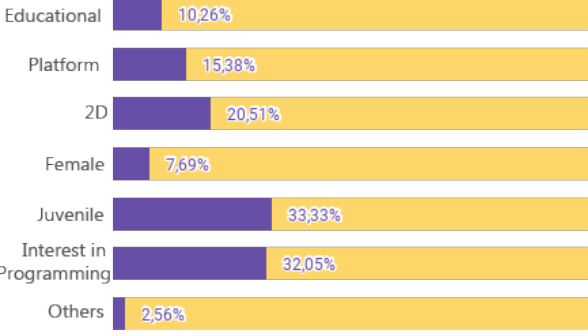
Figure 21. If so, what audience do you think it is intended for? - Test 1.